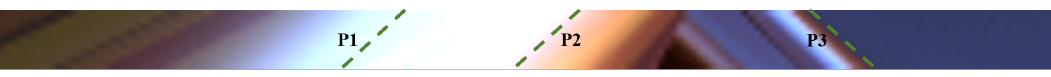
Figure 1. EPI for reflective (between P1 and P2) and texture-less (left from P3) regions. It’s clear that all pixels in these regions have the same RGB